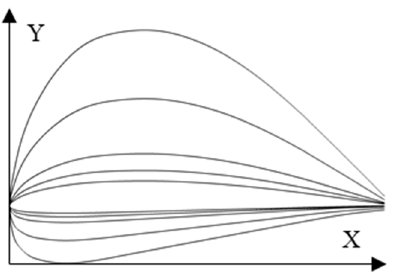
Figure 4. Affine transformation of Clark Y airfoil.